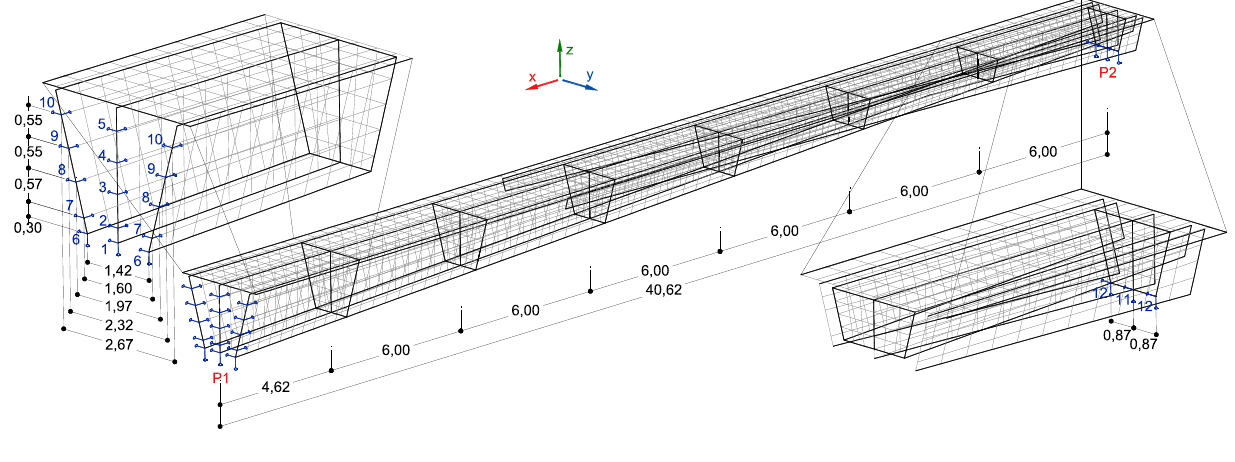
Figure 23. Numerical model of the structure [31].